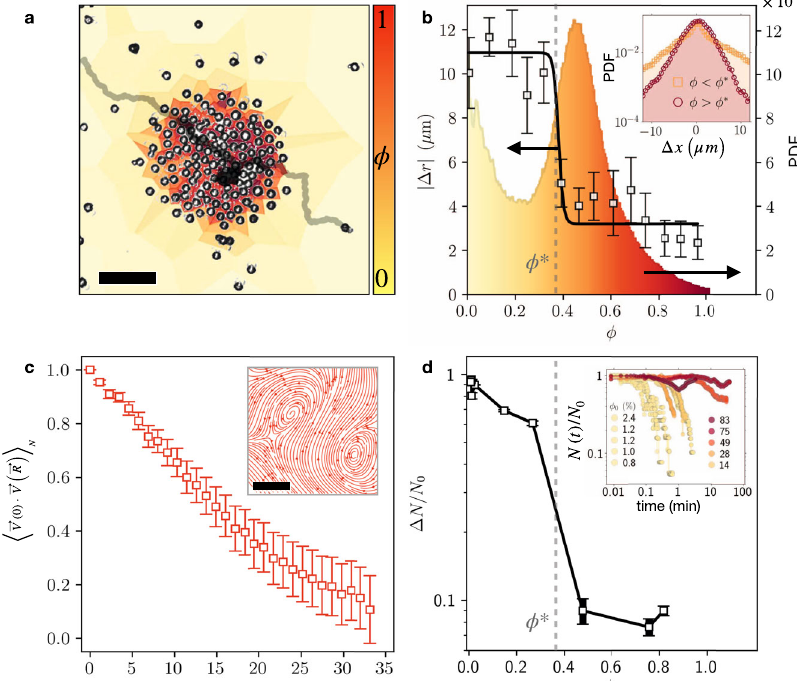
Fig. 3 At suf fi ciently high average area fraction, ϕ 0 , the swimmer population segregates into a long-lived state of dilute and dense fl uids. a The instantaneous local density of each swimmer is measured from the inverse size of the corresponding Voronoi cell. Both the dilute and the dense phases are fl uid as can be seen from the trace of an individual swimmer crossing the different phases, moving slower (darker trace) in the denser region (see Supplementary Video 1). b the probability for fi nding an individual swimmer at a speci fi c local density shows two characteristic phases. Particle displacement over a fi xed interval (5 seconds) shows a sharp decrease above the local concentration of ϕ * = 0.38 (black squares). Inset shows the displacement probability distribution function for an individual swimmer below (yellow squares) and above (red circles) ϕ * , showing that the ballistic motion at low density has a PDF with heavier tails than the PDF of the collision dominated displacement at high densities. c velocity correlation function within the dense phase indicates fl ows correlate on a length scale much larger than the swimmer size. Inset shows streamlines measured using particle image velocimetry, displaying an internal fl ow structure consistent with the swimmers slightly repulsive nature (see Supplementary Information). d at lower initial concentration, ϕ 0 ≤ 0.28, most of the swimmers will disperse, Δ N ≫ N 0 , within a few seconds up to minutes. At higher initial concentrations, ϕ ≥ 0.49, the swarm forms a persistent crowded state, which remains throughout the measurement time (hours). Inset shows temporal evolution. Scale 0 bars are 20 μ